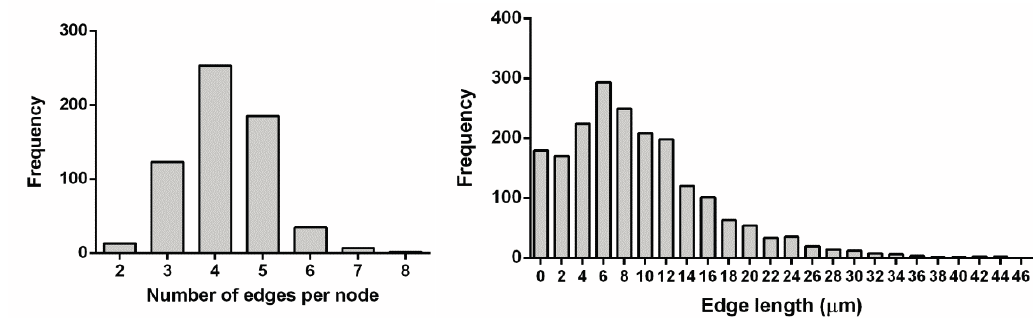
Figure 2. Fundamental characteristics of the FRC network: the nodes represent the FRC body and edges are physical links between them. The edges per node- and the edge length distributions for the T cell zone FRC network. Data obtained from n = 7 mice from two independent